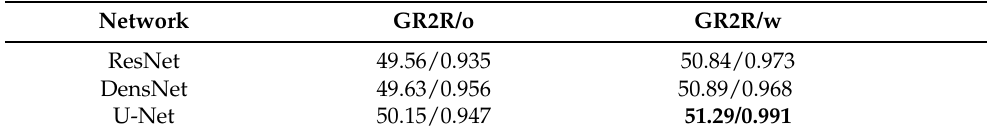
Table 4. Quantitative denoising results with or without generative noise module on SIDD valida- tion